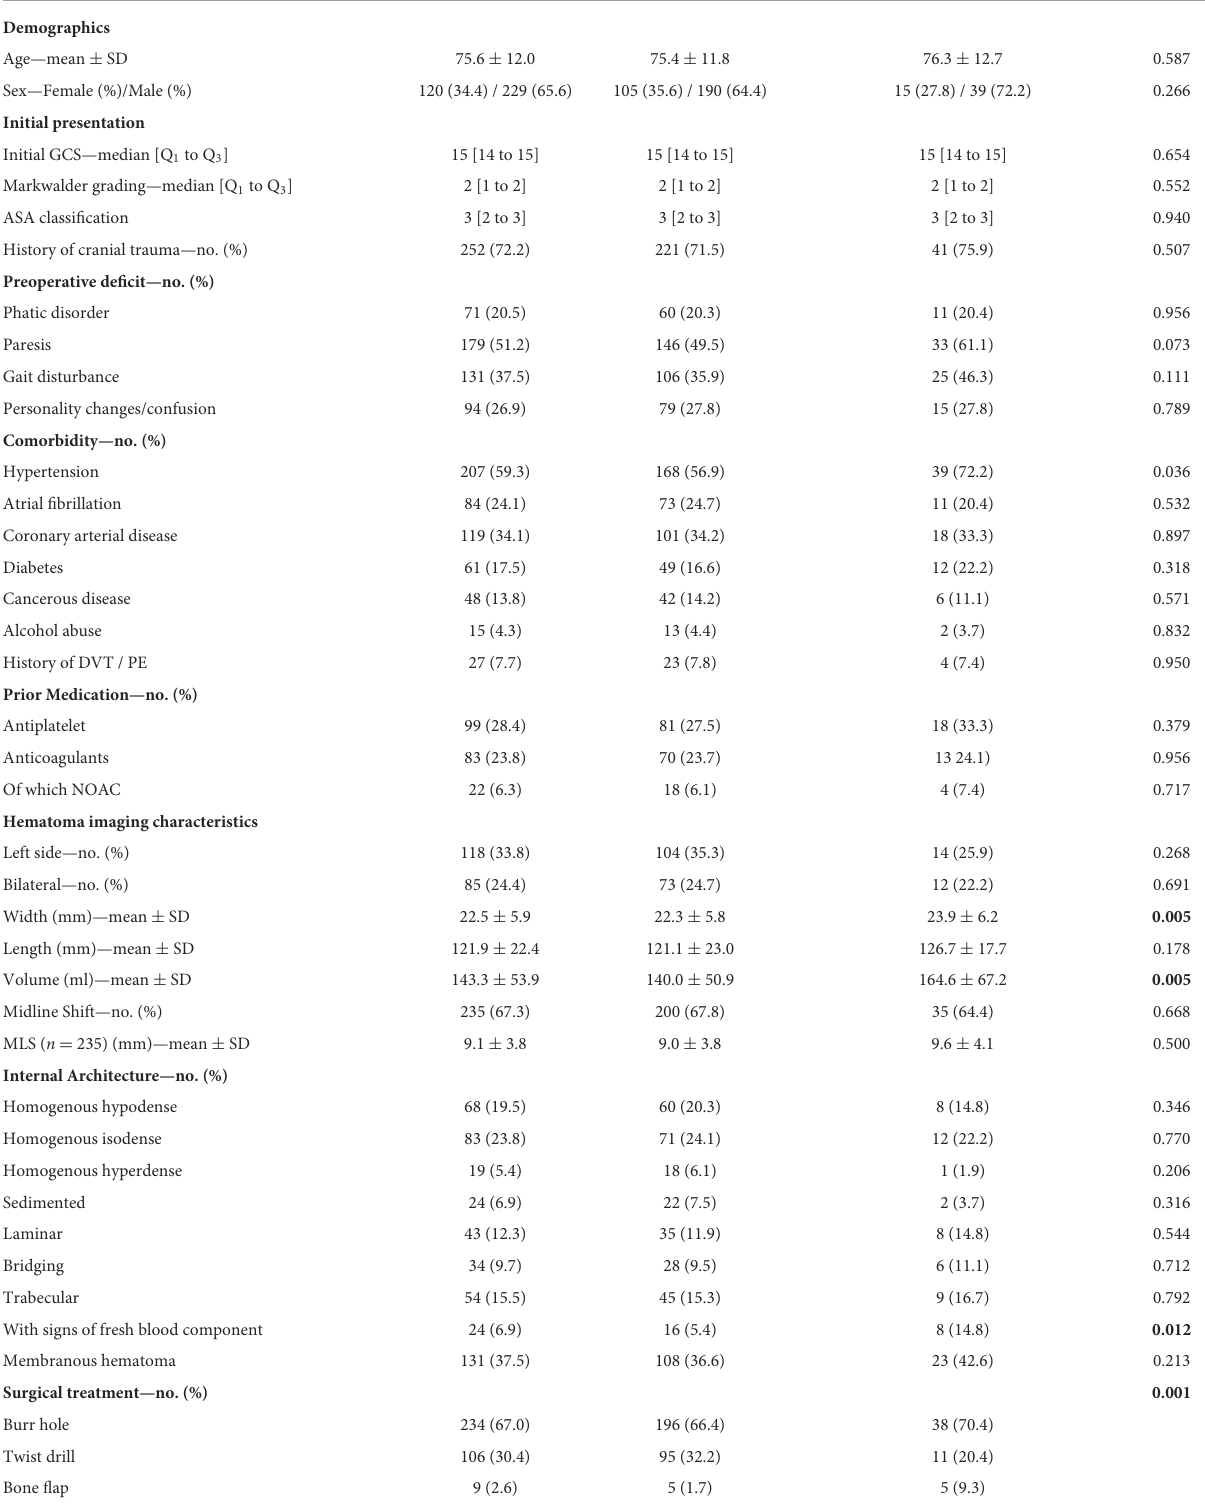
TABLE 1 Baseline characteristics, pre- and postoperative findings on CT imaging and outcome in chronic subdural hematoma patients with or without post-operative seizure. All ( n = 349) No seizure ( n = 295) Post-operative seizure ( n = 54) p